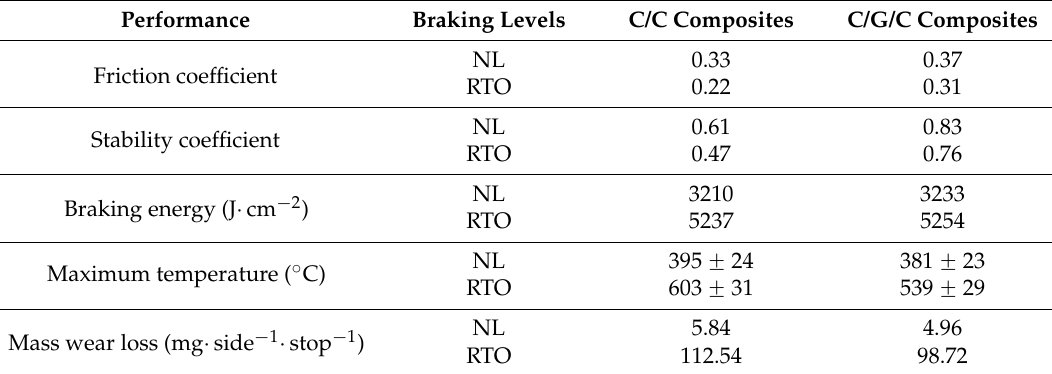
Table 3. Results of braking experiments at the NL and RTO braking